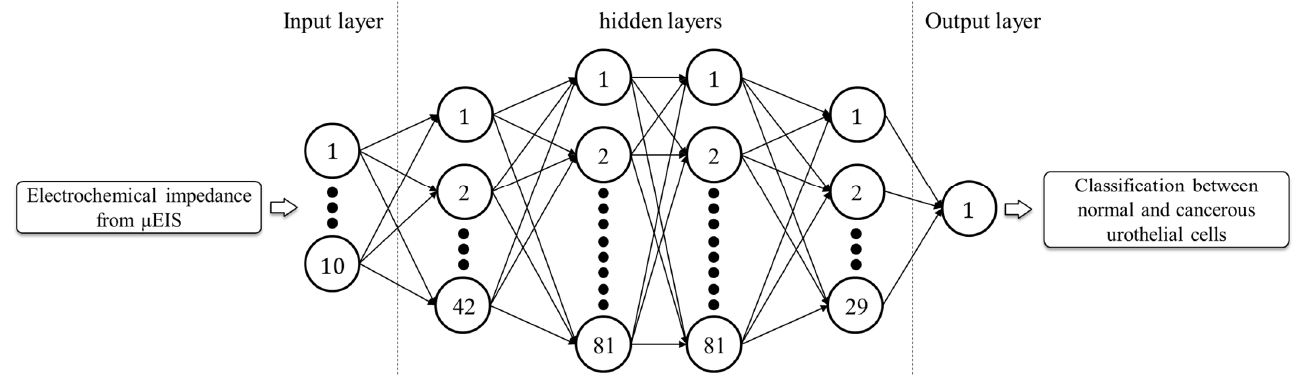
Figure 7. Hyperparameter optimization using BO with ten ‐ fold cross ‐ validation for BPNN. The number of layers and neurons that led to the best cross ‐ validation accuracy of BPNN are shown. The number in the last neuron of each layer represents the number of neurons comprising the layer. Table 1. Optimization conditions and results of the six ML models.